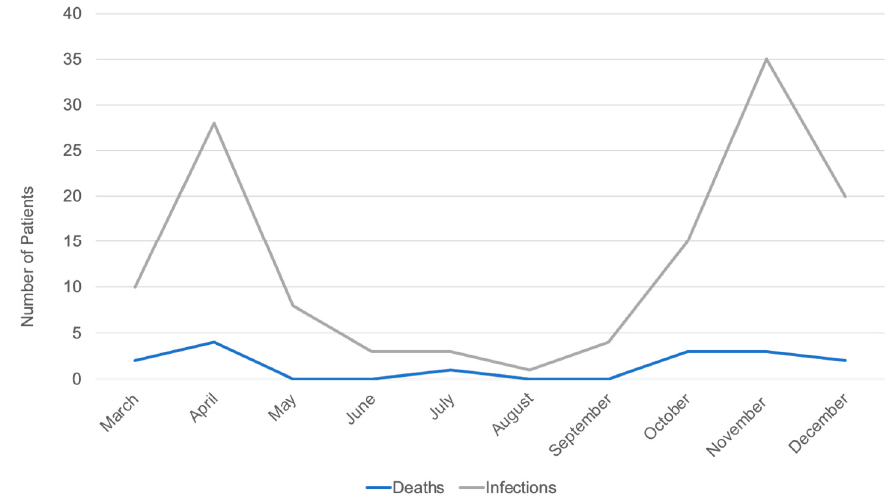
Figure 4. Evolution of SARS-CoV-2 infection and deaths due to COVID-19 disease.